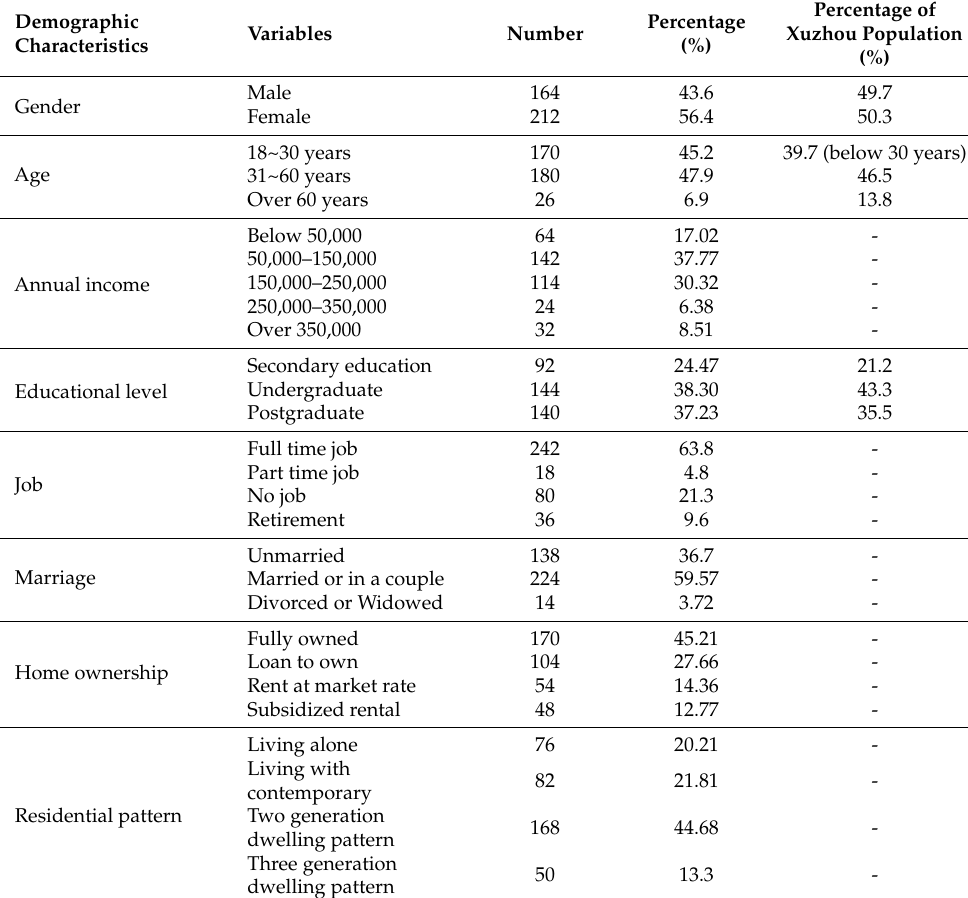
Table 1. Demographic characteristics of samples ( n =